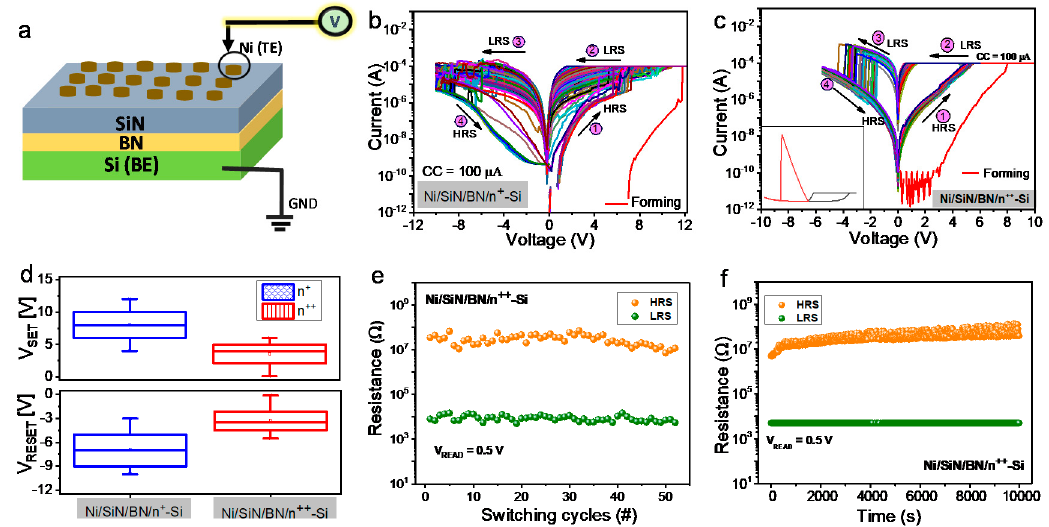
Figure 1. ( a ) Schematic of the Ni / SiN / BN / Si stack and bias configuration. Typical I–V characteristics of ( b ) Ni / SiN / BN / n + -Si device and ( c ) Ni / SiN / BN / n ++ -Si device (inset is linear scale for filamentary-like switching); ( d ) Box chart of set and reset voltages of the Ni / SiN / BN / n + -Si and Ni / SiN / BN / n ++ -Si devices; ( e ) Endurance; ( f ) Retention of Ni / SiN / BN / n ++ -Si device.